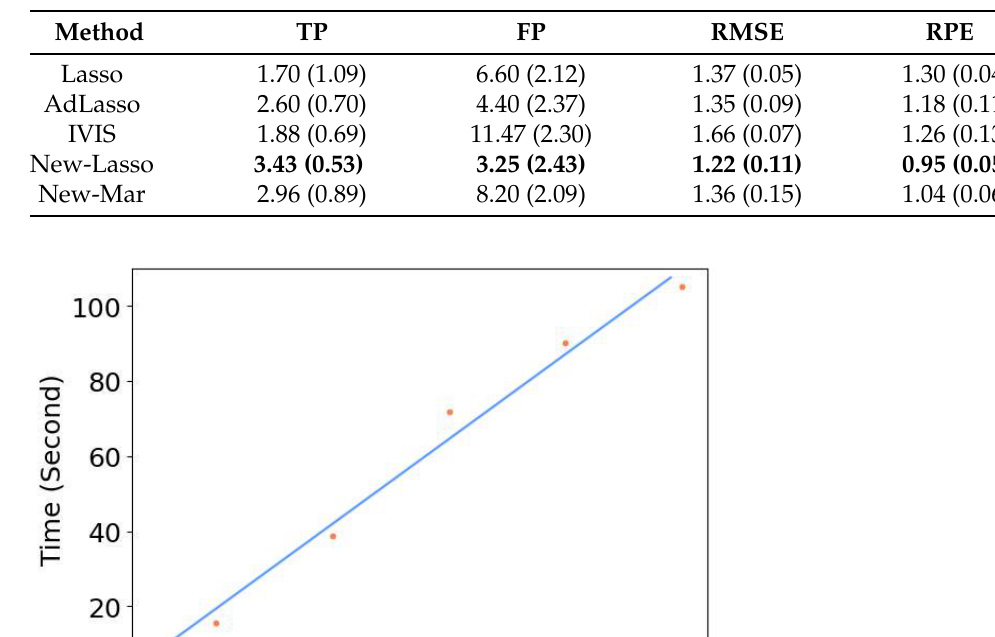
Table A5. Simulation results for SKCM dataset. Each cell shows the mean (sd). The bold represents the best value.